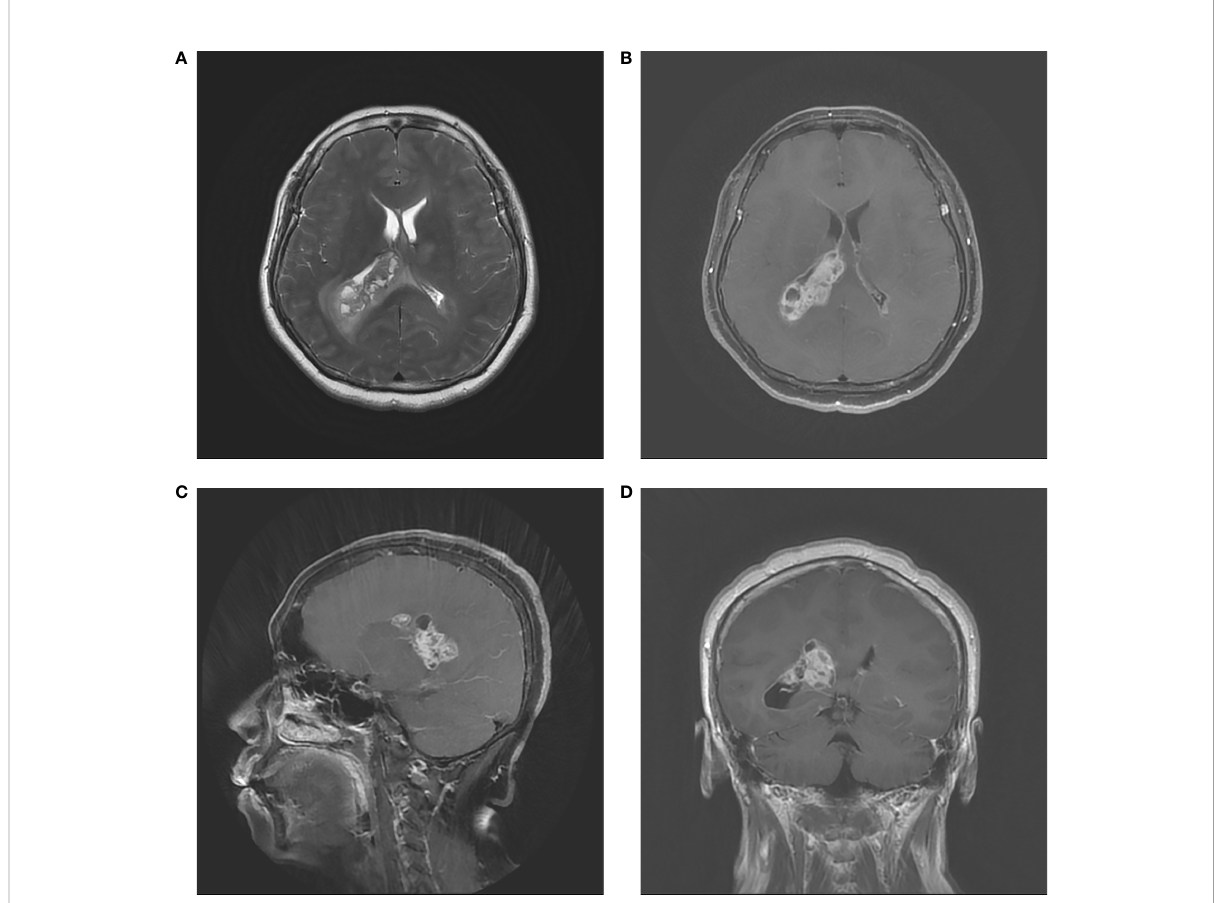
FIGURE 2 Preoperative MRI. (A) Axial T2 – weighted image. (B) Axial contrast MRI. (C) Coronal contrast MRI. (D) Sagittal contrast MRI. The tumor had a diameter of 50 mm in and located in the trigone region of the right lateral ventricle. MRI showed in fi ltrative, irregular borders, inhomogeneous contrast enhancement, and rim